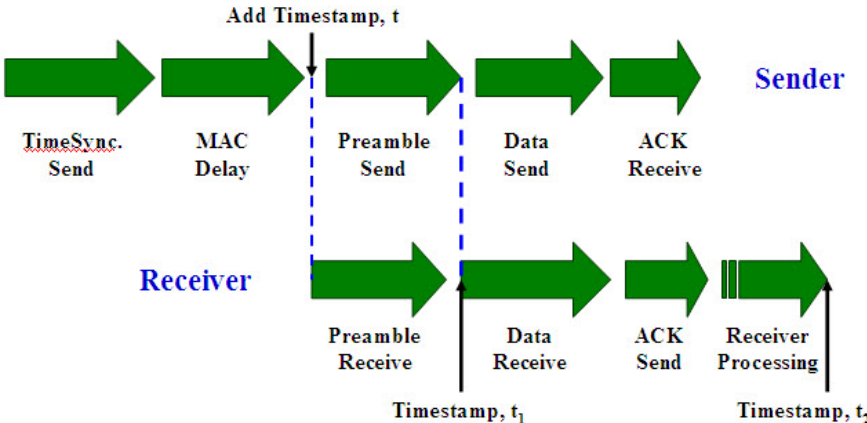
Figure 9. Time transfer path in a Mica